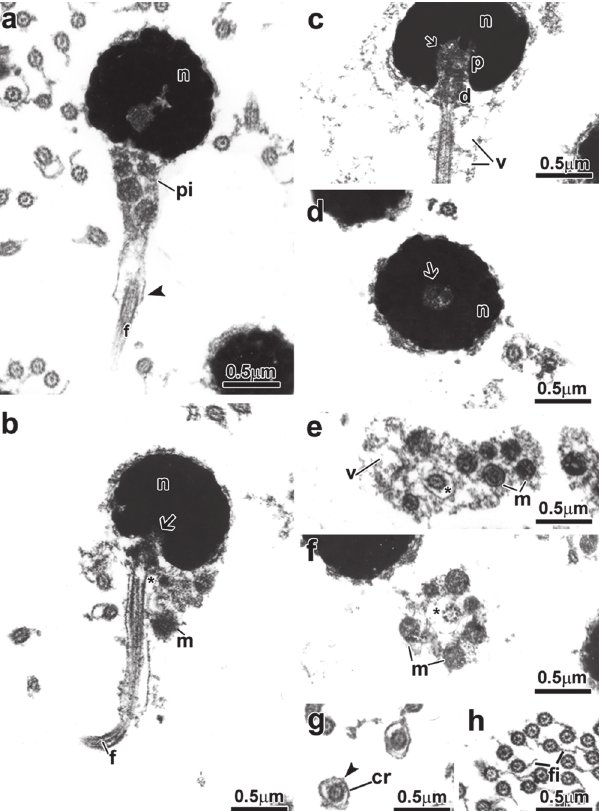
Fig. 2. Spermatozoon of Bryconalestes longipinnis . a, b, c: longitudinal sections. d, e, f, g, h: transverse sections from top to posterior region. The nucleus (n) is spherical and lies medial to the flagellum (f). The centriolar complex (p, d) and nuclear fossa (arrow) is medial. The proximal centriole (p) is in a right angle relative to the distal centriole (d). The cytoplasmic canal is present (asterisk). The midpiece (pi) is asymmetrical, and contains the spherical mitochondria (m), vesicles (v) and a cytoplasmic sleeve (arrowhead). The flagellum has lateral fins (fi). Legends: cr: concentric membranous rings, d: distal centriole, f: flagellum, fi: lateral fins, m: mitochondria, n: nucleus, p: proximal centriole, v: vesicle, asterisk: cytoplasmic canal, arrow: nuclear fossa, arrowhead: cytoplasmic sleeve.